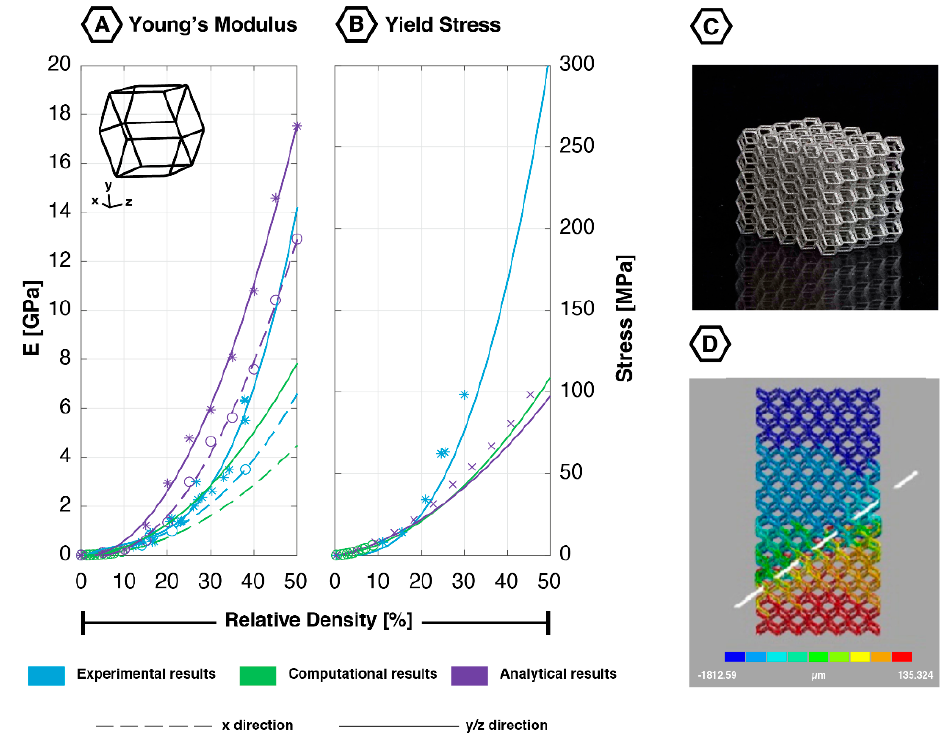
Figure 4. Mechanical properties of the rhombic dodecahedron unit cell based on experimental, computational, and analytical data: ( A ) Young’s modulus [12,18,19,21,22,45,51,55]; ( B ) yield stress [18,21,22]; ( C ) additively manufactured rhombic dodecahedron lattice (5 × 5 × 5 unit cells); ( D ) fatigue failure surface (45-degree shear band) showing the deformation in the loading direction; reprinted with permission from Ref. [20] © 2016 Elsevier.